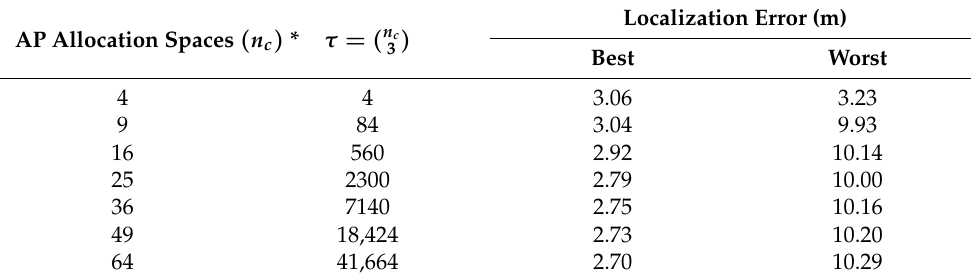
Table 3. Ninety-five percent of cumulative error results obtained for 3 APs, 16 RPs and 10 samples per test. Different values for the AP allocation spaces are simulated.